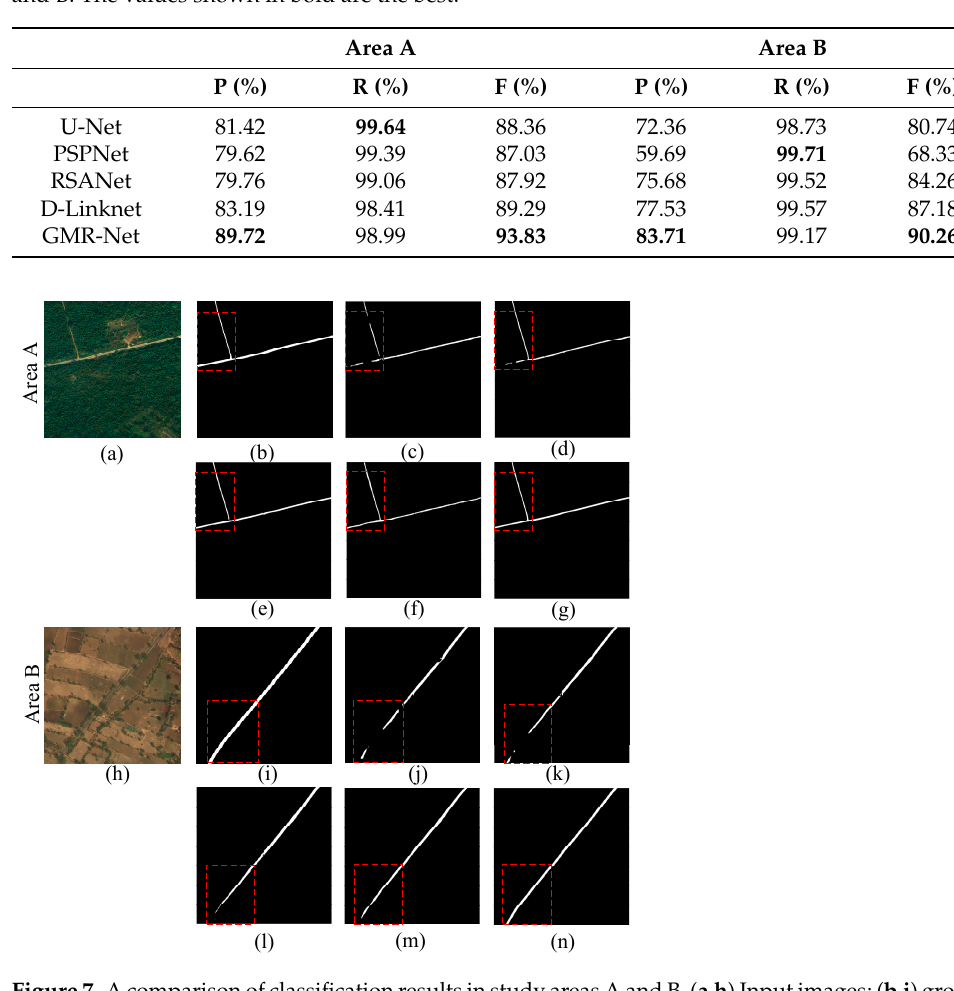
Table 5. A results comparison between the GMR-Net method and other methods in research areas A and B. The values shown in bold are the best.